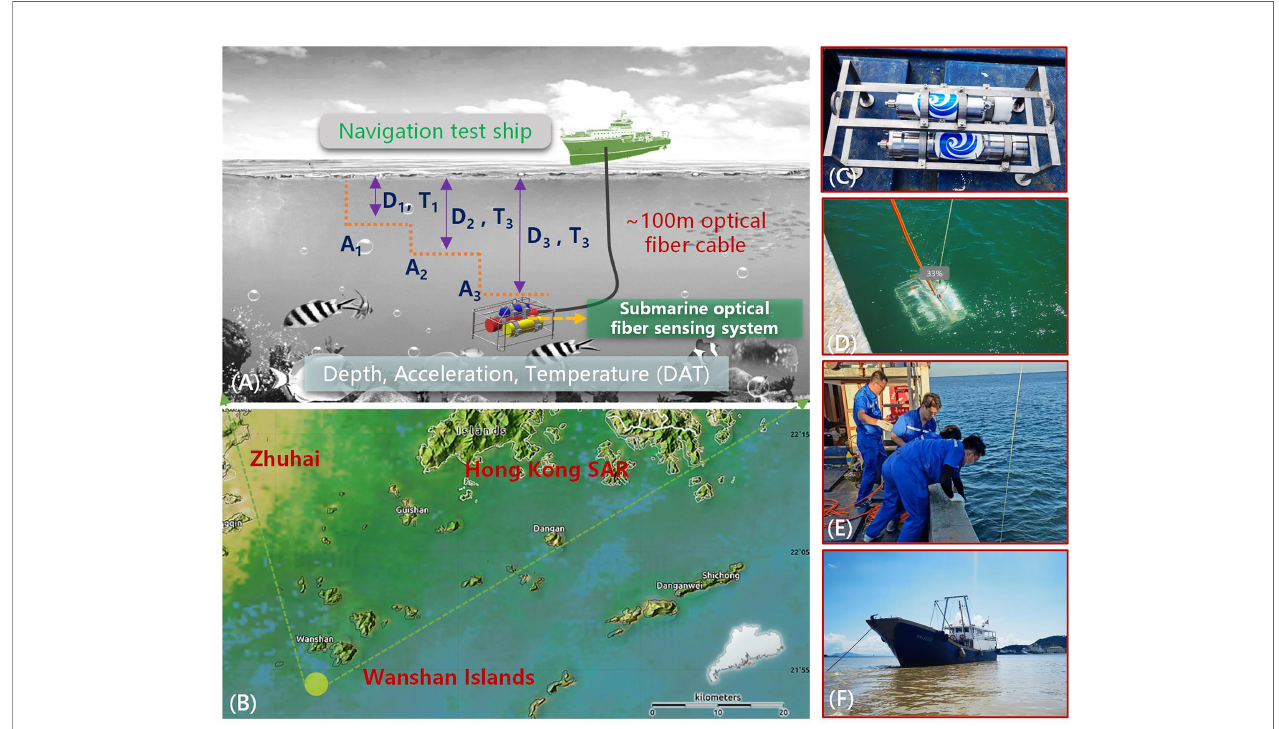
FIGURE 4 | Illustration of the sea test conducted to verify the submarine optical fi ber sensing system in a speci fi c area close to Pearl River Estuary in China, where panel (A) is the test route employed to introduce three different conditions in terms of depth, acceleration, and temperature, panel (B) shows the test area near Wanshan Islands, and panels (C – F) are the photos captured during the fi eld